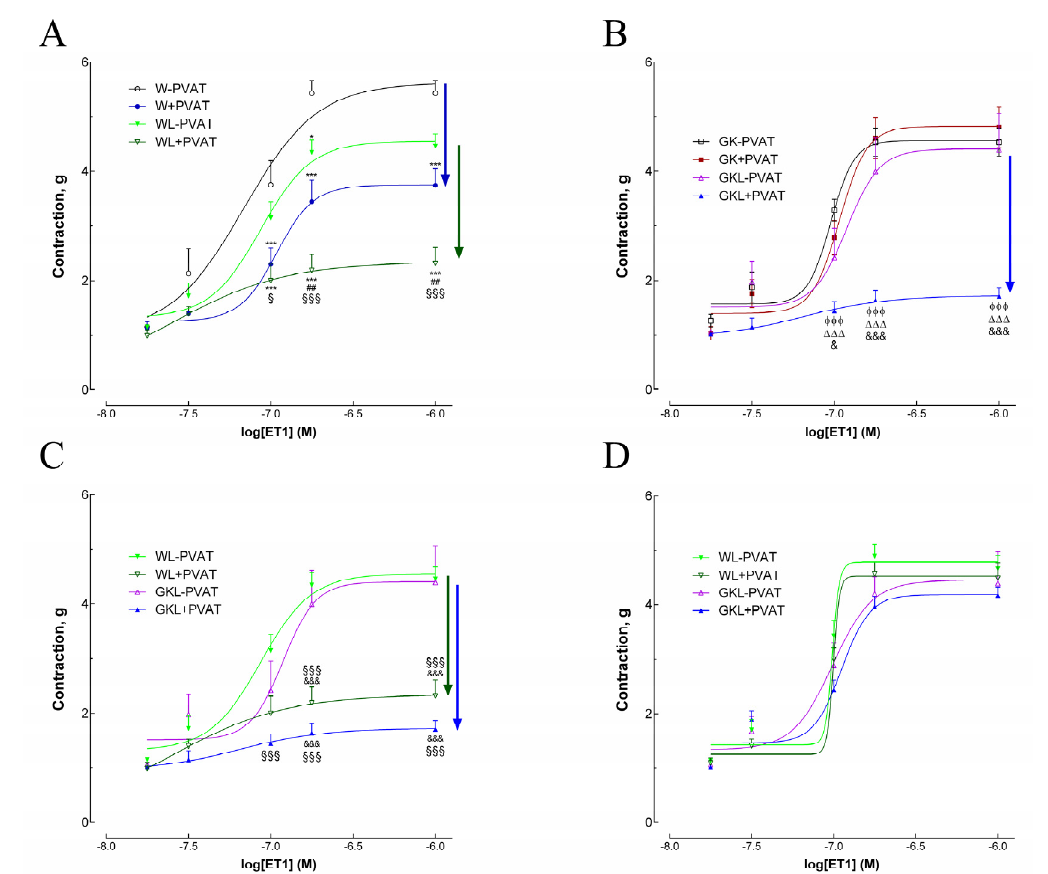
Figure 3. Effects of luteolin on contraction responses to endothelin-1 (ET1) in aortas of Wistar (W) and diabetic Goto- Kakizaki (GK) rats in the absence ( − PVAT) or presence of PVAT (+PVAT). The effect of luteolin is highlighted in panel ( A ) and ( B ) for W and GK aortas, respectively. Luteolin recovered the anticontractile PVAT phenotype typical of normal W in diabetic GK rats (panel B , C ). ( D ) Effects of luteolin on contraction responses to ET1 in aortas of W and GK rats in the presence of 4-aminopiridine, a voltage-dependent potassium channel (Kv) inhibitor. Luteolin treatment promoted a substantial PVAT anticontractile effect in aortic rings (panel B , C ) lost after treatment with 4-aminopiridine (panel D ). Data are expressed as mean ± SE ( n = 10). * p < 0.05, *** p < 0.001 vs. W-PVAT group; ## p < 0.01 vs. W + PVAT group; § p < 0.05, §§§ p < 0.001 vs. WL-PVAT group; ϕϕϕ p < 0.001 vs. GK-PVAT group; ∆∆∆ p < 0.001 vs. GK + PVAT group; & p < 0.05, &&& p < 0.001 vs. GKL-PVAT.